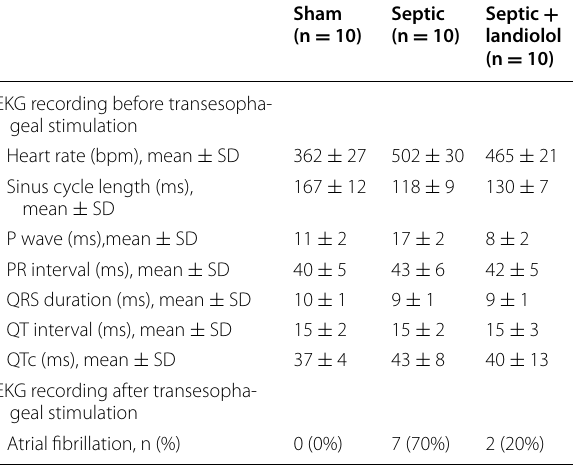
Table 1 EKG recording before and after transesophageal electric pacing